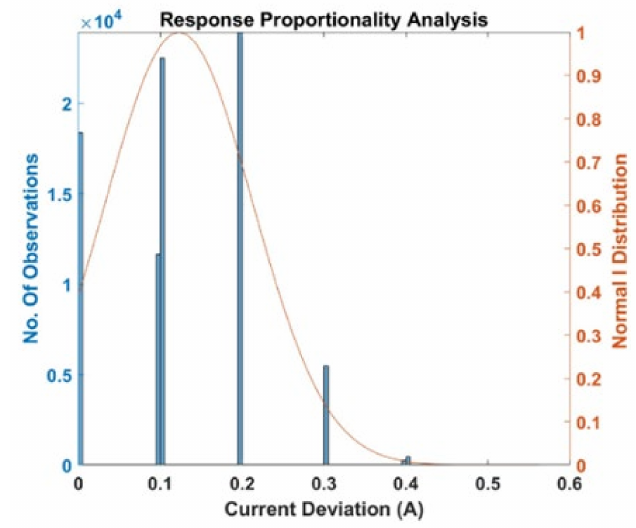
Figure 22. Number of observations of measurement signal deviation from the